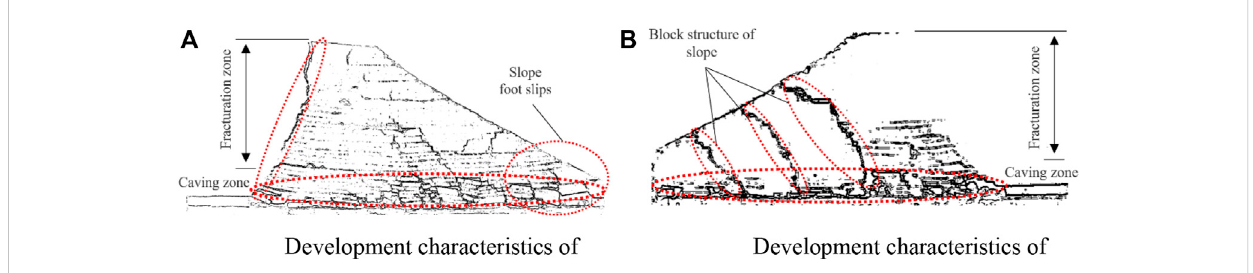
FIGURE 6 Final state of overburden fracture development in the slope model of Na ’ er Coal Mine during the mining under the gully. (A) Development characteristics of fractures during the mining toward the gully. (B) Development characteristics of fractures during the mining backward the gully.